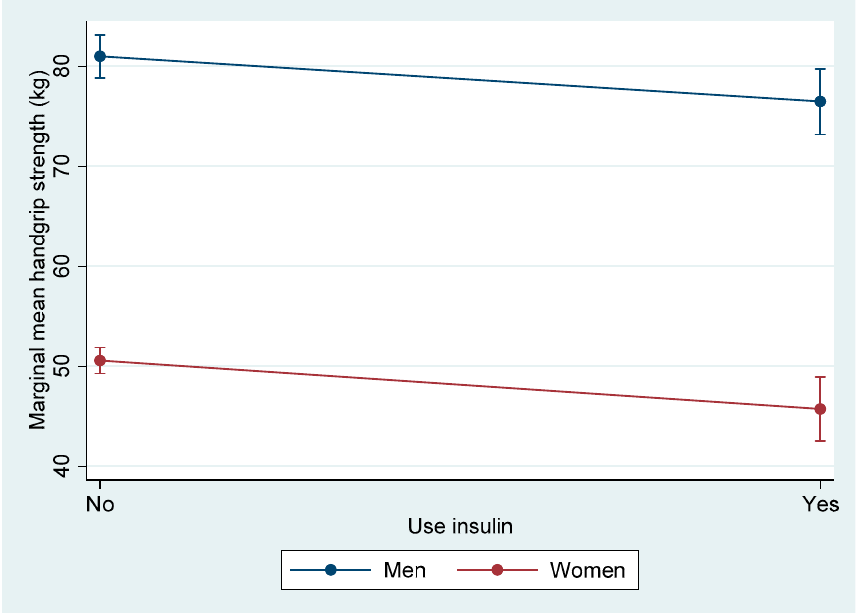
Figure 2. Marginal mean handgrip strength by insulin use in men and women. Note: Values were mean (95% CI), adjusted for age and race.